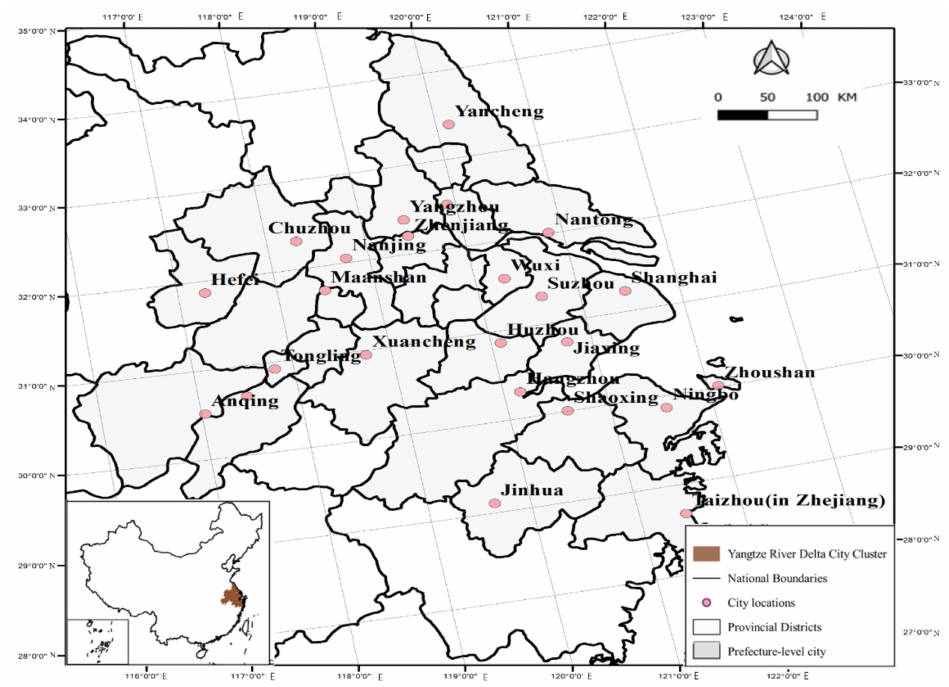
Figure 1. Map of urban agglomeration in the Yangtze River